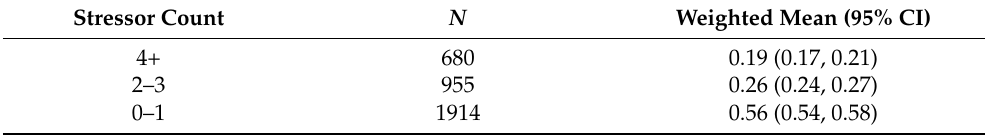
Table 2. Distribution of number of household challenges reported by PRAMS survey